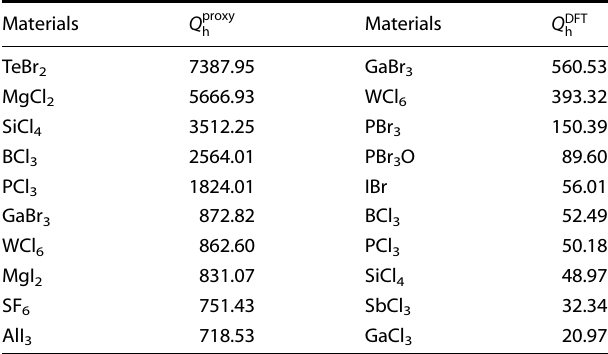
Table 1. Comparison of Q h from Newnham ’ s proxy and DFT